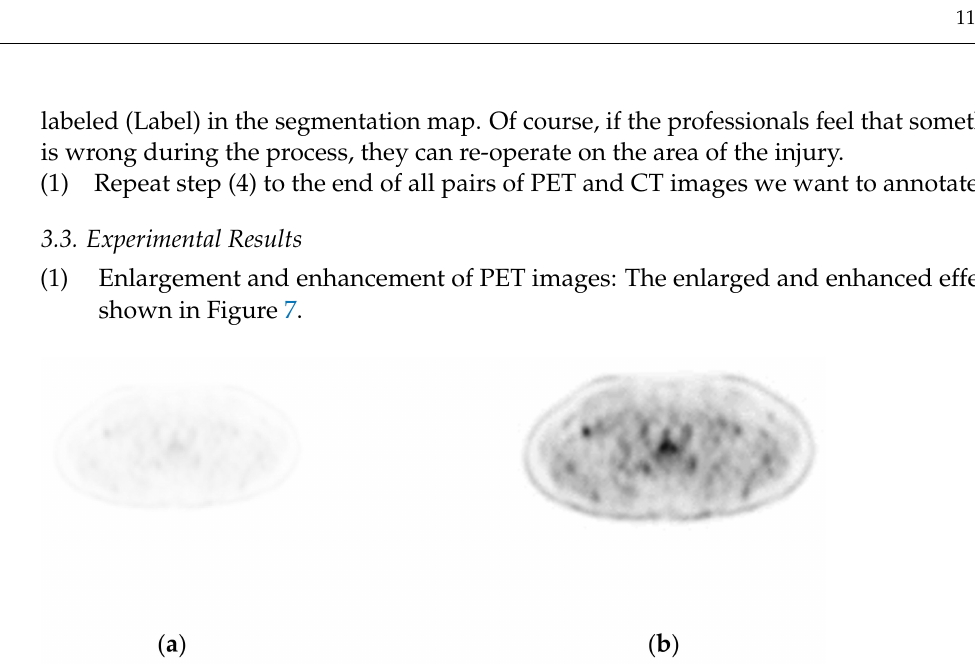
Figure 7. PET image enhancement. ( a ) The original PET image (168 × 168). ( b ) The enhanced PET image (512 × 512).